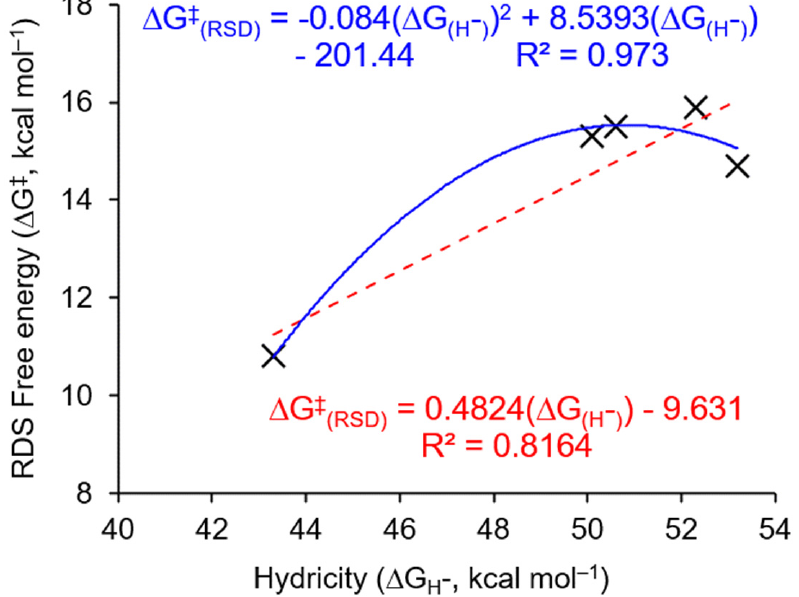
Figure 7. The fitting between the ∆ G ‡ of RDS for Ni–H complexes I to V and the computed hydricities. The blue line represents the second-order polynomial fitting and the red line represents the linear fitting.